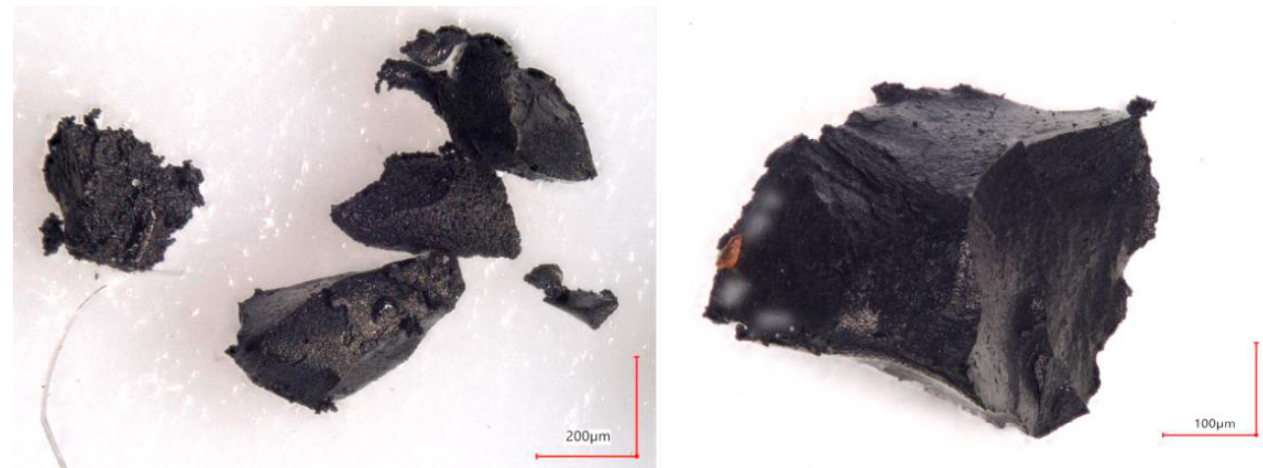
Figure 1. GTR particles after grinding process.